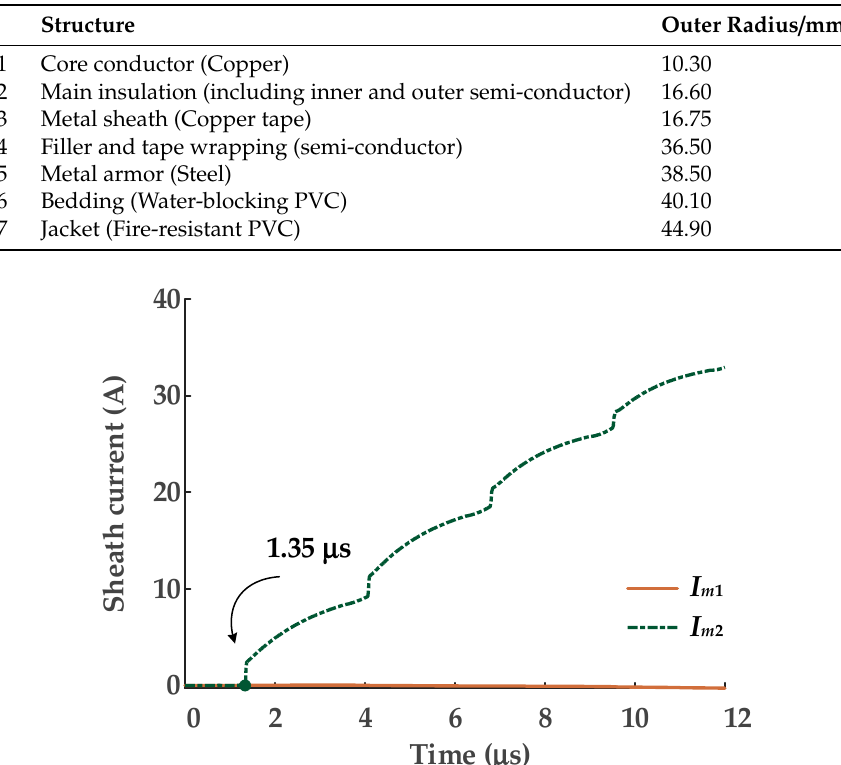
Figure 20. The number of the sheath current samples in each cluster. Clearly, cluster 1 has the fewest samples and, from examination of Figure 20, the sample distribution is very concentrated, i.e., as discussed, related to the difference in arrival times at the terminals. To illustrate the concentrated distribution of the samples from cluster 1, the scatter diagram of the sheath current I m 2 is replotted in Figure 21, where the corresponding samples of the cluster 1 are highlighted. 135